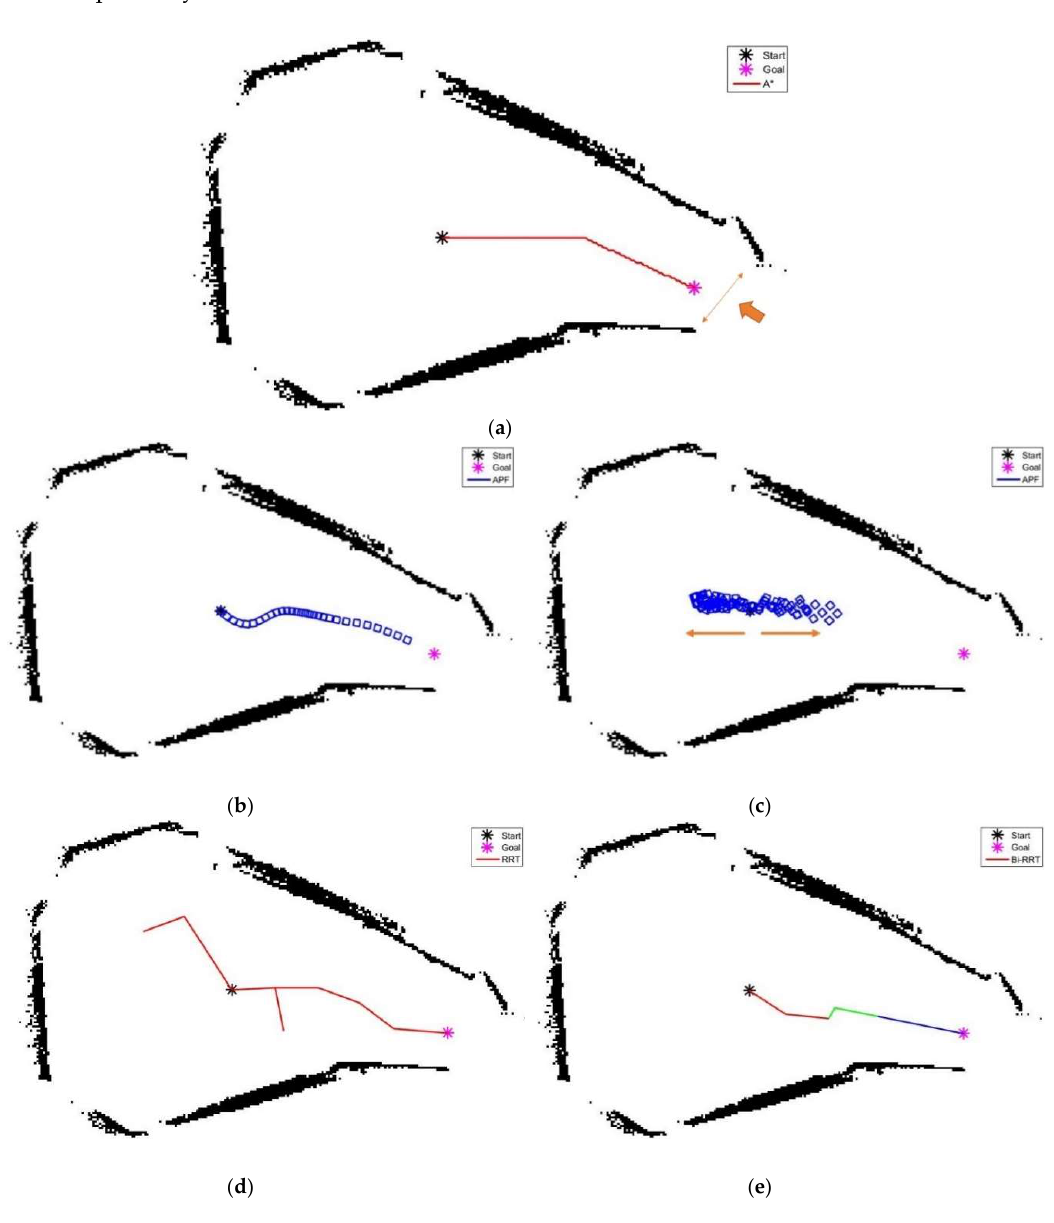
Figure 17. Generated path, for Dataset II, using: ( a ) A* algorithm; ( b ) first iteration of APF; ( c ) second iteration of APF; ( d ) RRT; and ( e ) bidirectional RRT.